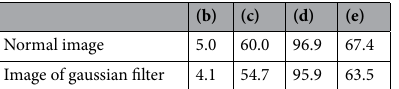
Table 1. Probability of judging that pollination is possible (%).